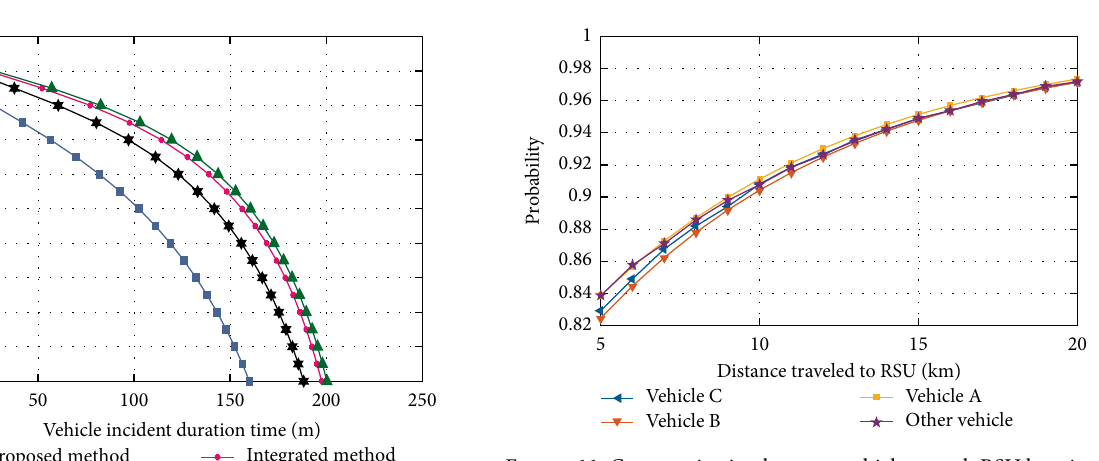
Figure 11: Communication between vehicle to each RSU location.